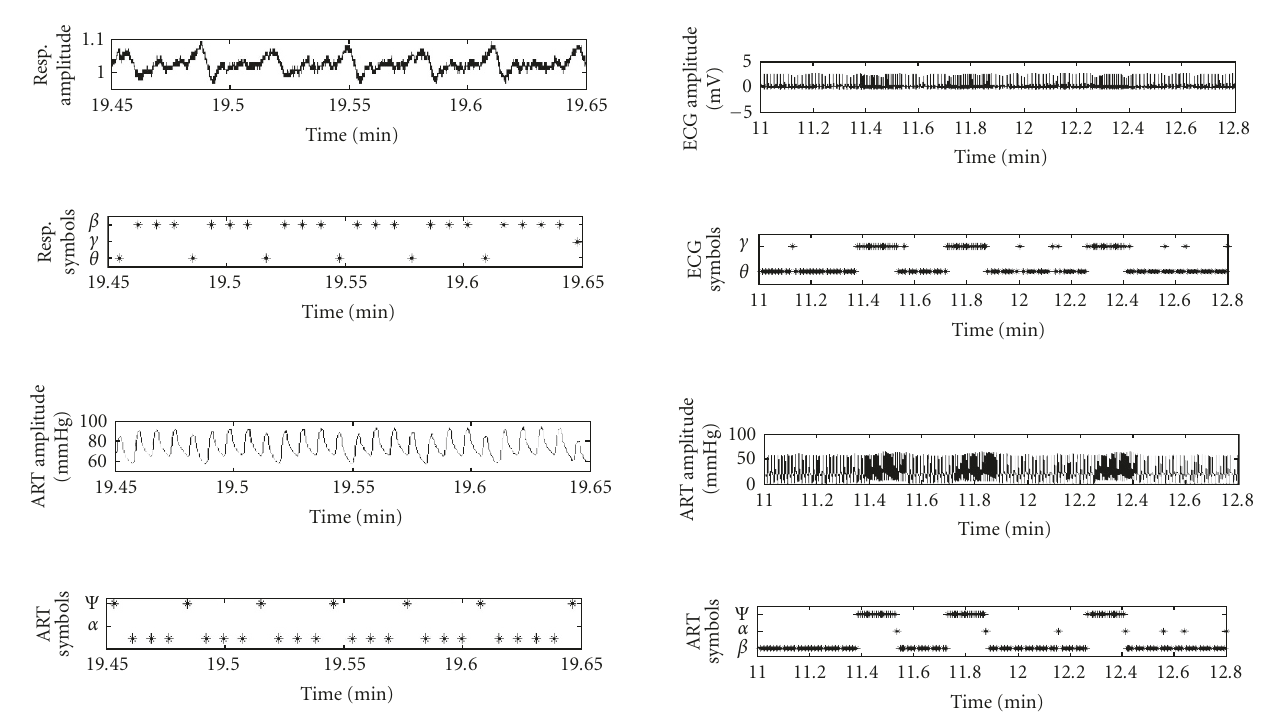
Figure 14: Respiration and arterial blood pressure signals for a pa- tient with pulsus paradoxus.